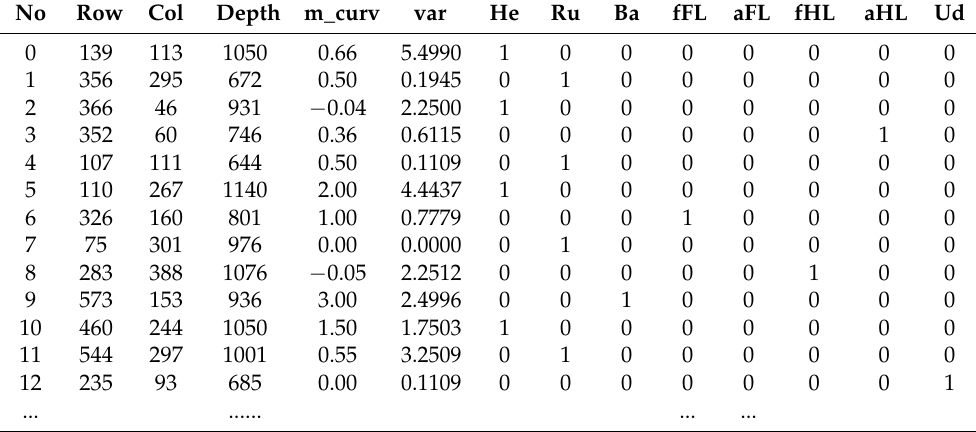
Table 1. Extract from the data set of camera position ’S’ before standardisation. The last eight columns provide the one-hot encoded body parts to which the pixels belong: head (He), rump (Ru), back (Ba), facing foreleg (fFL), averted foreleg (aFL), facing foreleg (fHL), averted hindleg (aHL), udder (Ud). Columns two to six hold the pixel properties row index, column index, depth value in mm, mean curvature (m_curv) and variance (var) both calculated from the surrounding nine-pixel-square. No Row